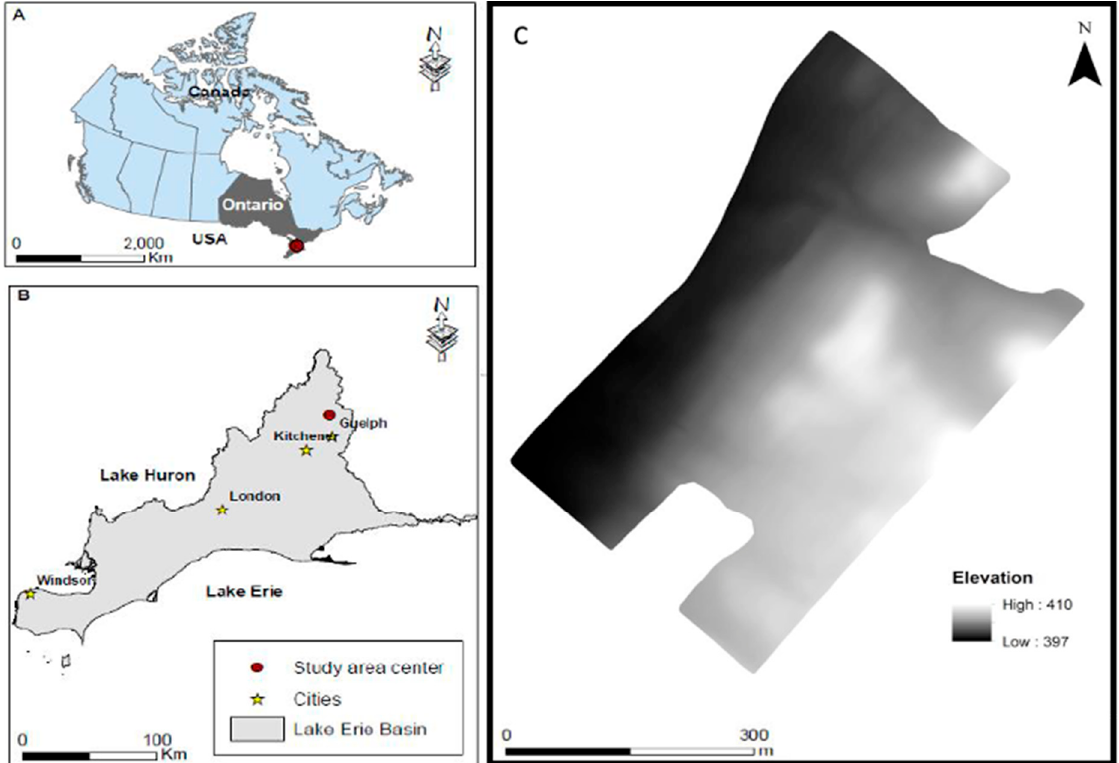
Figure 1. Maps showing the location of the study site in ( A ) southwestern Ontario within ( B ) the Lake Erie basin. ( C ) The study site with a topographic overview, adapted from [19].